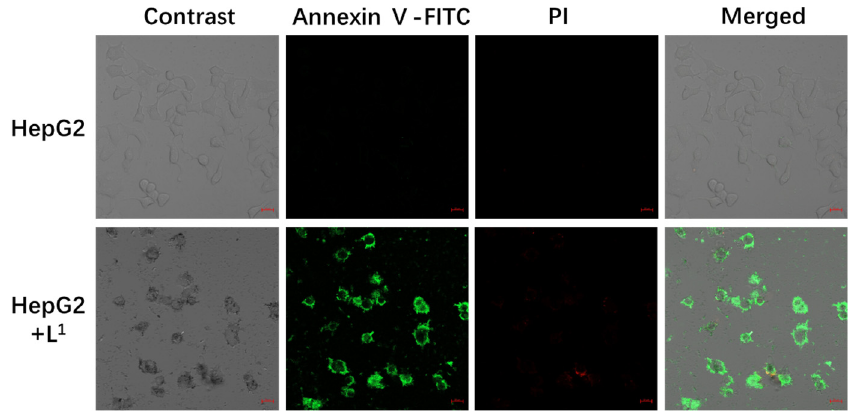
Figure 5. Confocal fluorescence images of HepG2 cells incubated with L 1 (25 μ g/mL) for 48 h at 37 °C. Scale bars are 20 μ m.